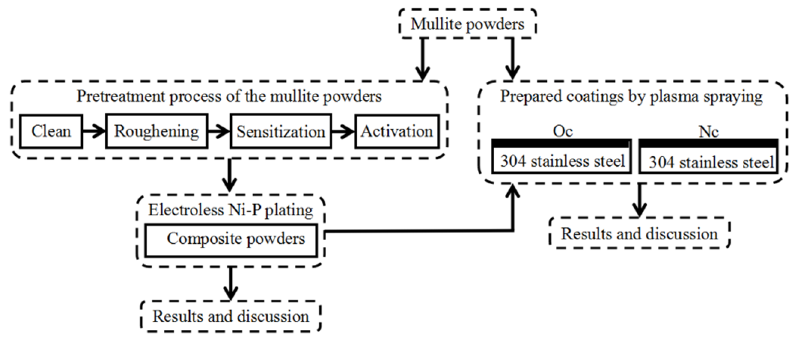
Figure 2. The flow chart of the experimental